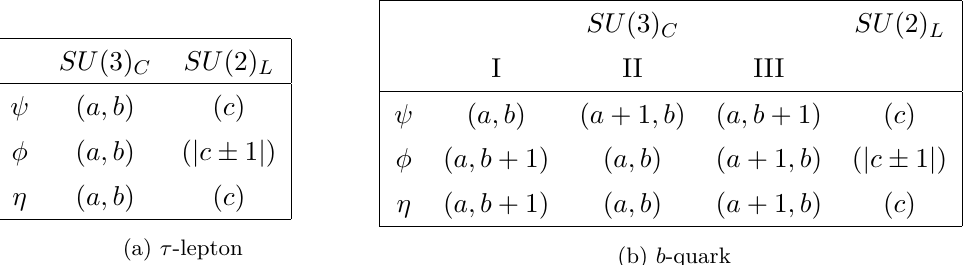
Table 1. Dynkin labels giving the allowed colour and weak-isospin assignments of the new fields in Class 1 for the τ -lepton (left) and b -quark (right). For the b -quark models there are three possible patterns for the SU (3) C assignments.